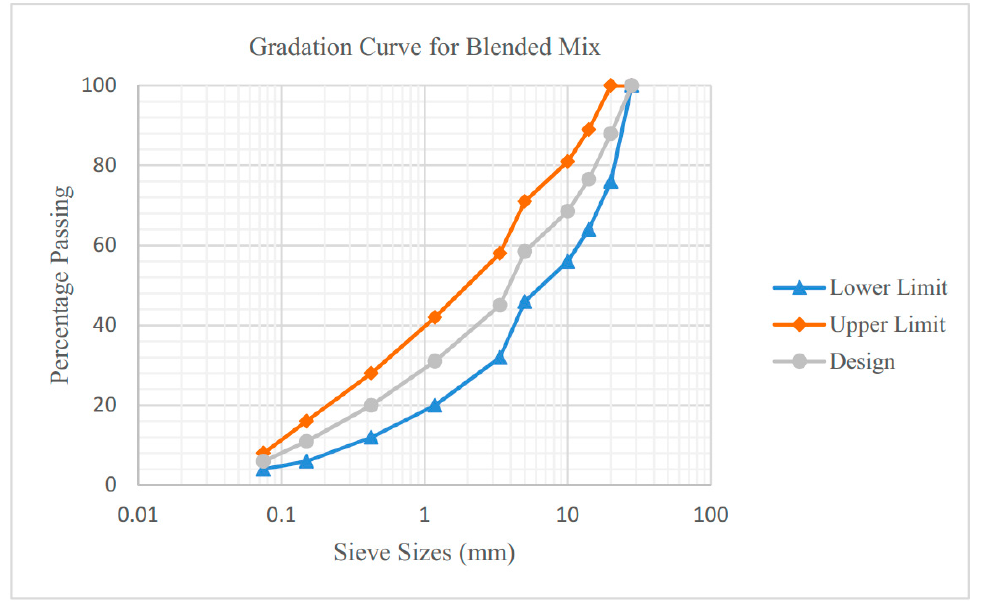
Figure 4. Gradation curve of blended mix.